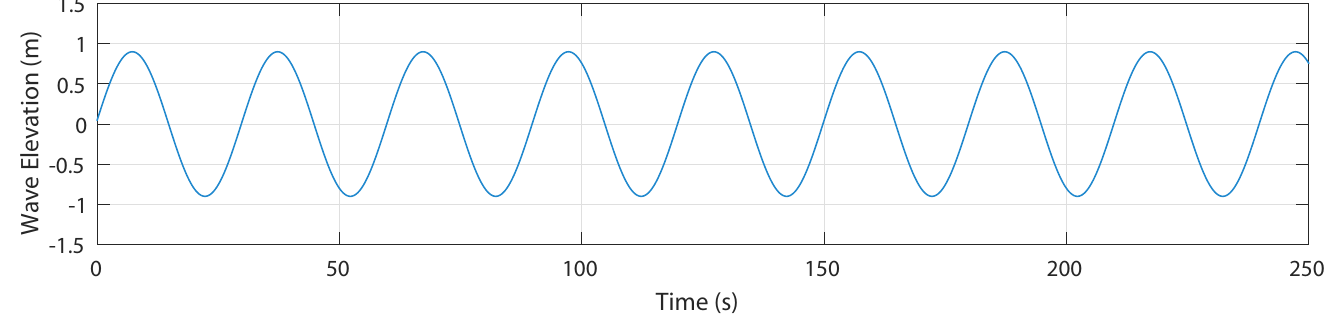
Figure 13. Wave elevation input.